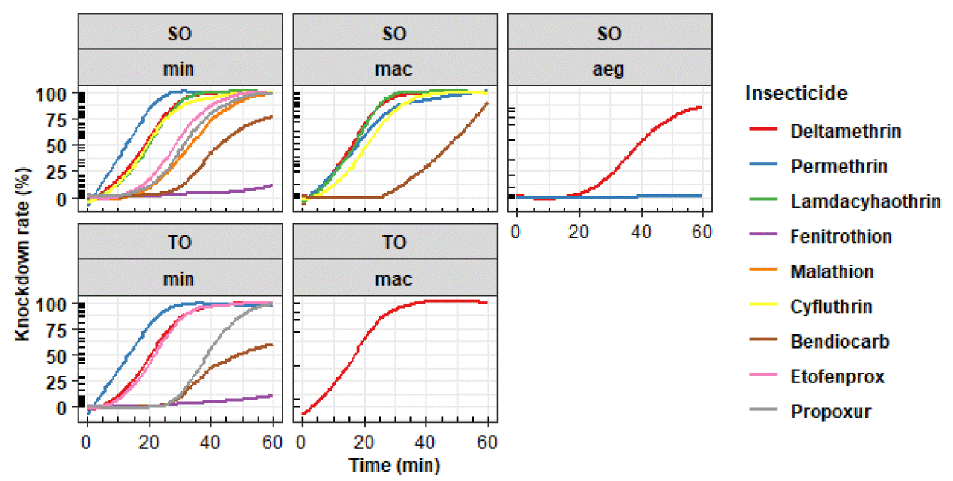
Figure 3. Knockdown rate of An. minimus s.l. (min), An. maculatus s.l. (mac) and Ae. aegypti (aeg) from Suan Oi (SO) and Tala Oka (TO) villages against different classes of insecticide. Table 3. Genotype and allele frequencies of the V1016G, F1534C kdr mutations in F1 Ae. aegypti from Suan Oi village.